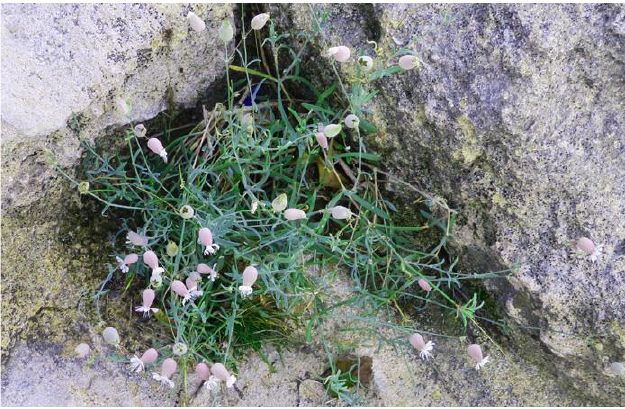
Figure 12. Silene vulgaris subsp. tenoreana